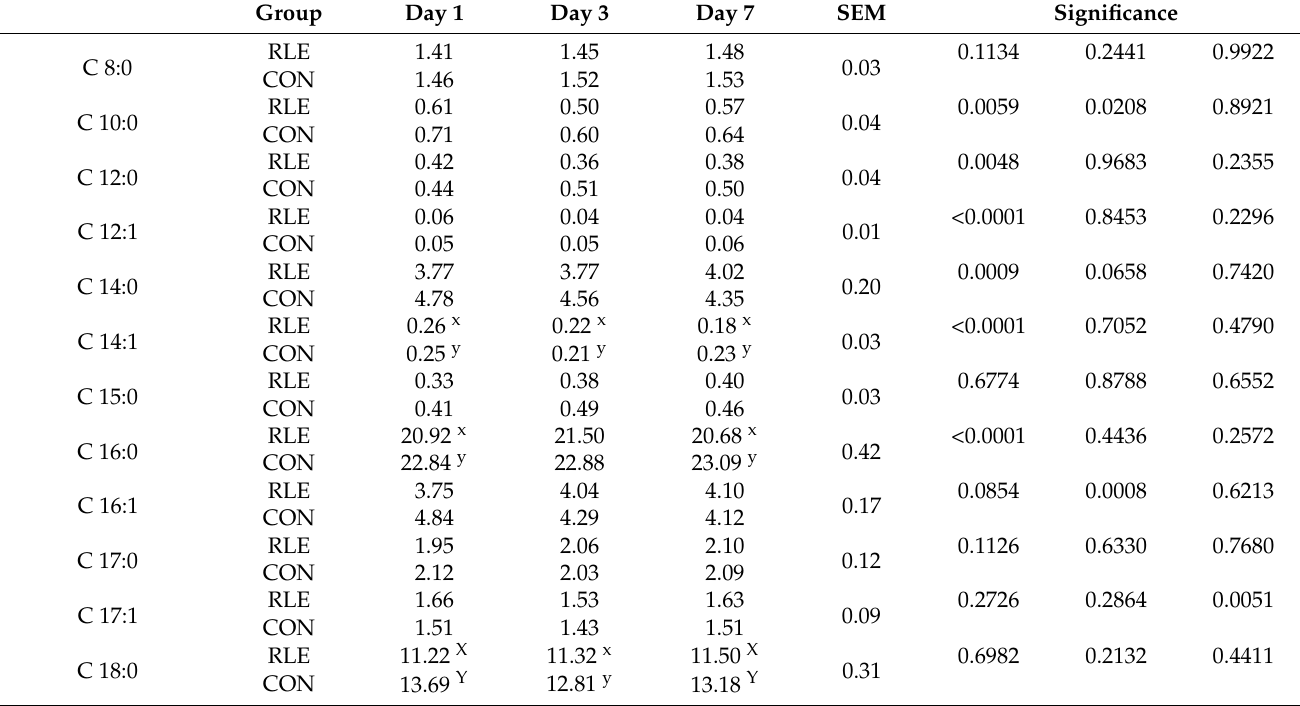
Table 6. Effect of including RLE in the diet and of aging time on kid’s meat fatty acids profile and groups (expressed as %